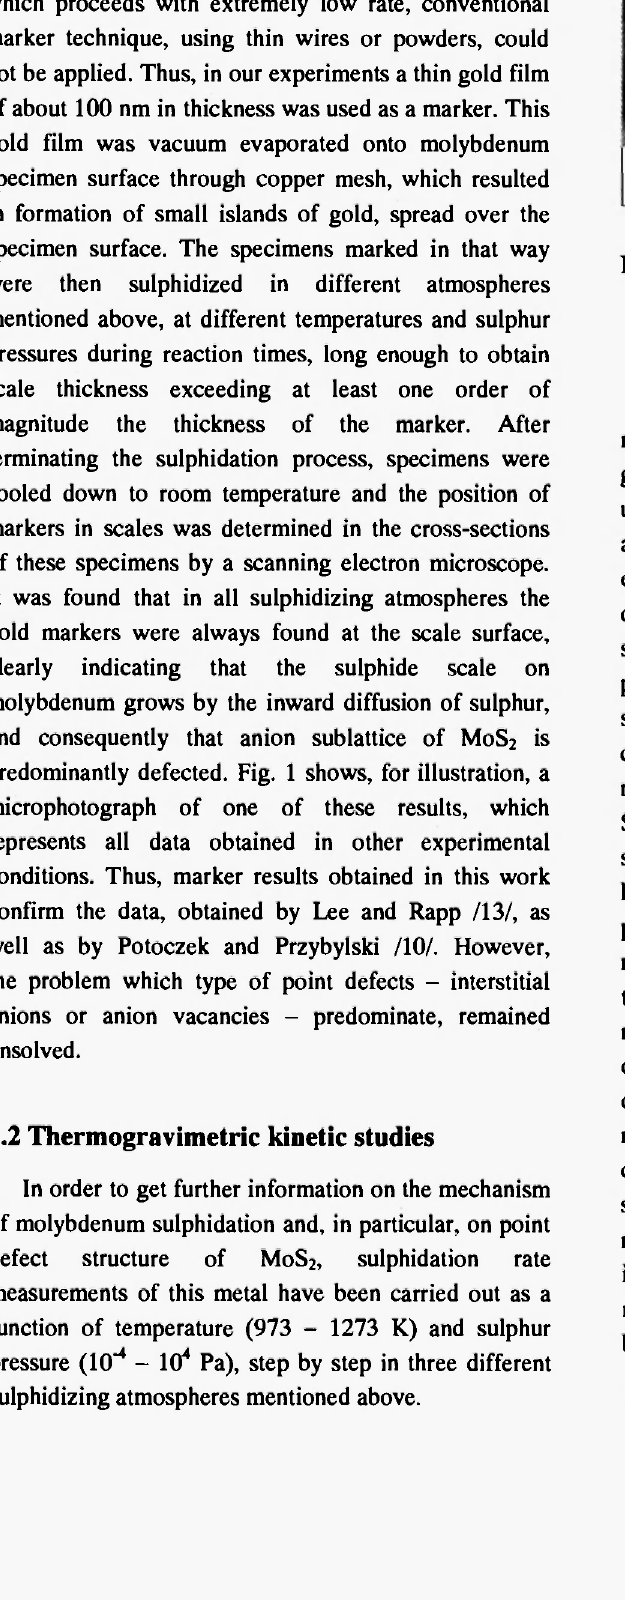
Fig. 1: The micrograph of the cross-section of the sulphide scale formed on molybdenum at 1173 Κ and sulphur pressure of 5